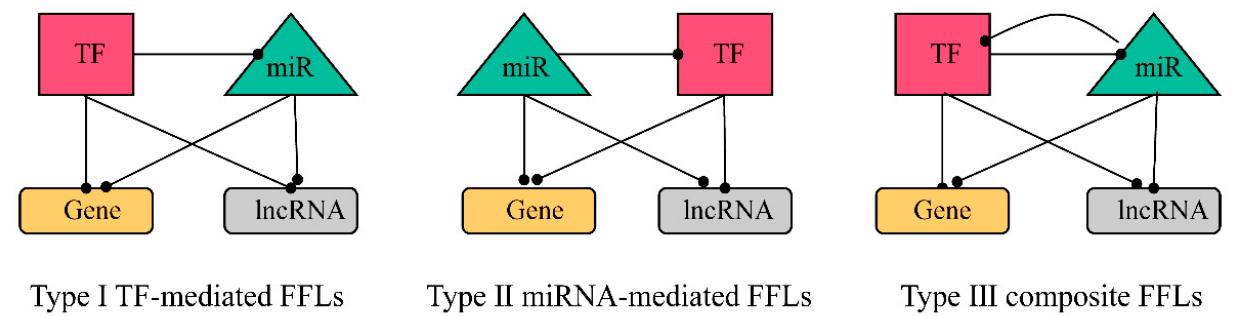
Figure 22. Three types of FFL subnetworks.